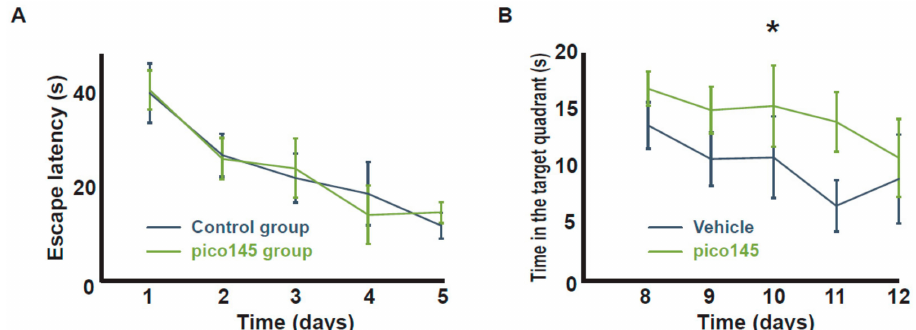
Figure 3. Pharmacological inhibition of TRPC1 / 4 / 5 impairs reference memory extinction. CTRL mice were submitted to a MWM training and thereafter were injected intraperitoneally with 0.1 mg kg − 1 weight pico145 (green line, n = 6) or with vehicle (blue line, n = 5). A . The average escape latencies (before injection). B . Memory extinction evaluated by repeated probe tests at days 8 to 12, one hour after injection of pico145 or vehicle. *: p < 0.05, two-way ANOVA.